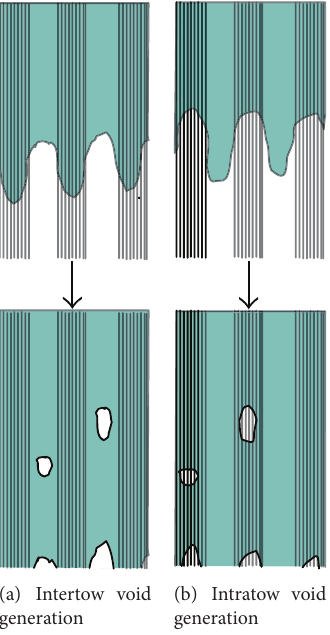
Figure 1: Illustration of inter- and intratow void